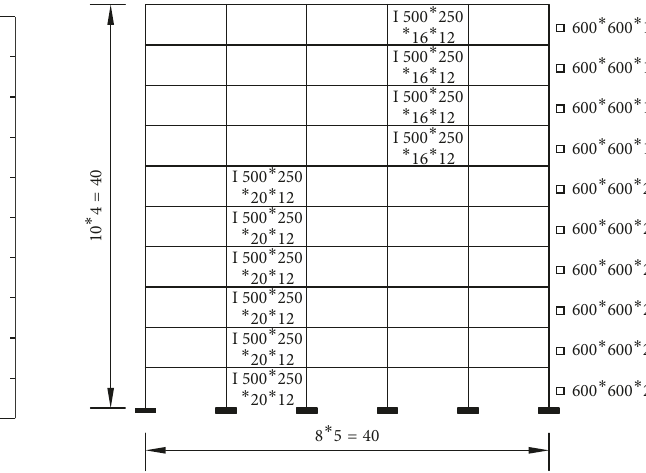
Figure 8: Analysis model of the steel frame structure.